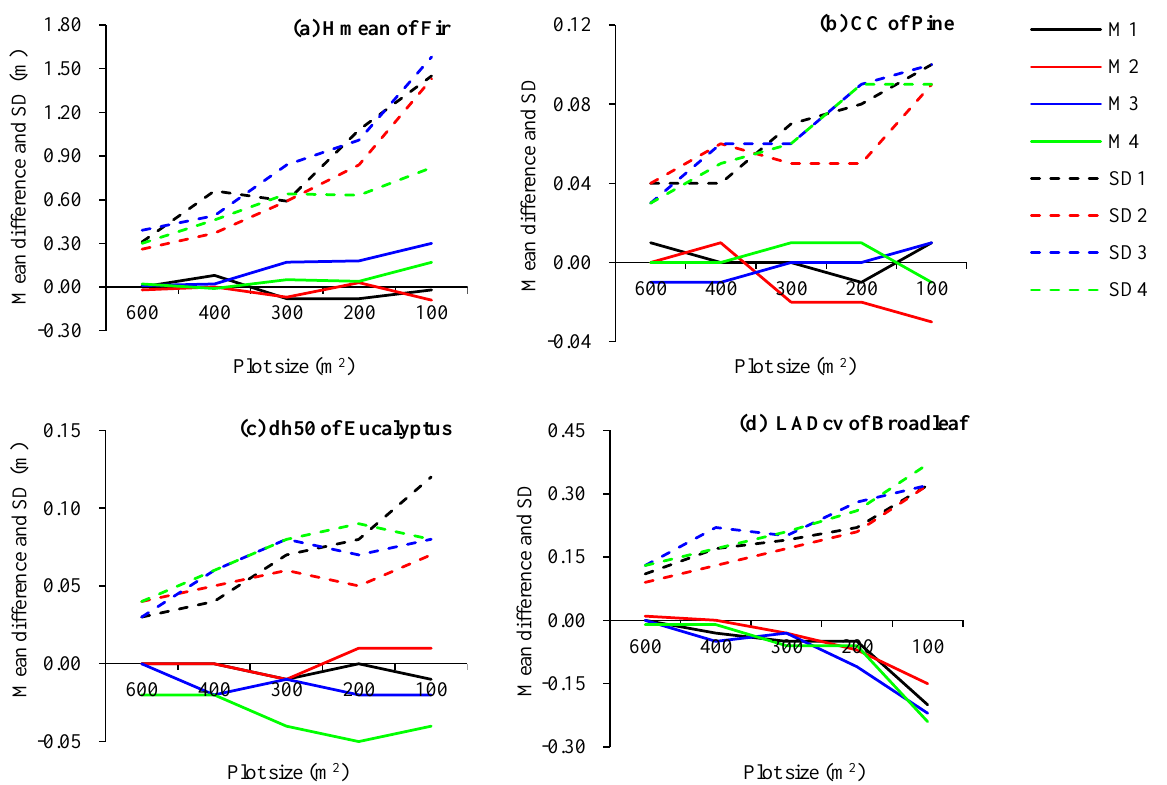
Figure 3. Mean and standard deviation of the difference in some LiDAR-derived metrics between plots of different sizes and the 900 m 2 plot. M1–M4 and SD1–SD4 were the mean differences and standard deviations for protocols 1–4, respectively. ( a ) Mean height of the Chinese fir forests, ( b ) canopy cover of the pine forests, ( c ) dp50 of the eucalyptus forests, and ( d ) LADcv of the broad-leaved forests.